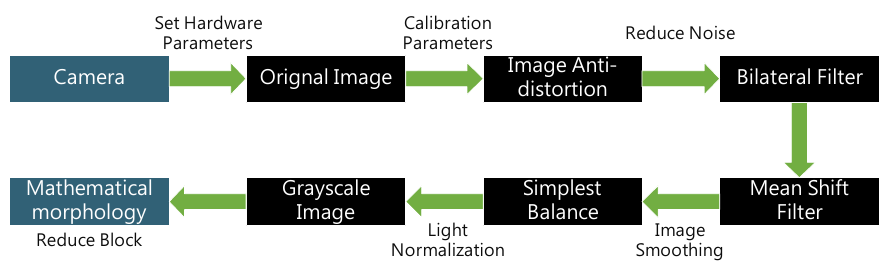
Figure 9. Image preprocessing flowchart.